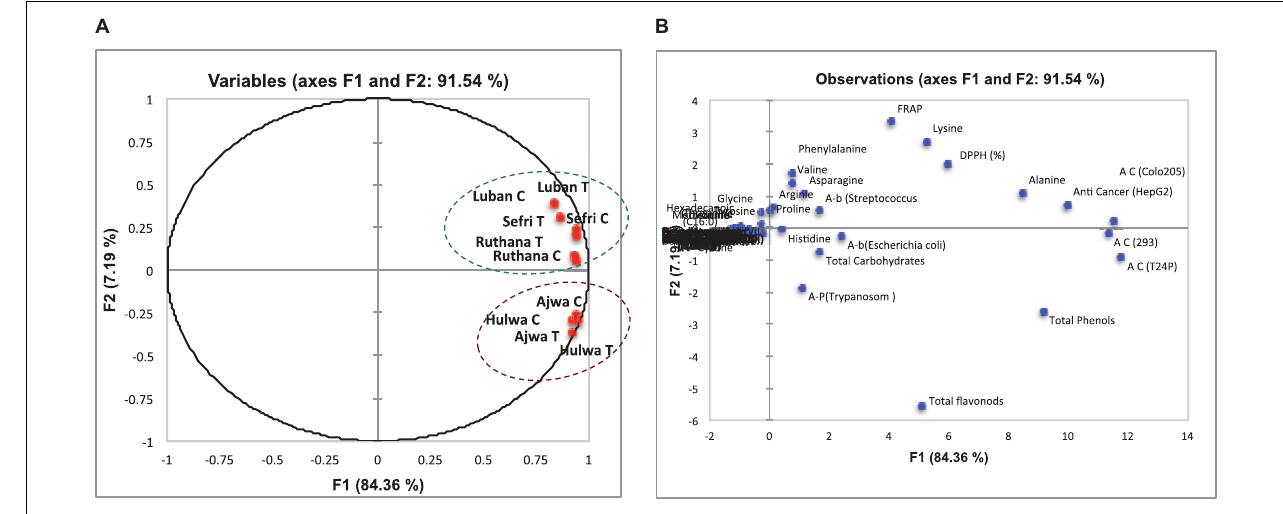
FIGURE 4 | Principal component analysis (PCA) of the measured metabolites, mineral concentrations and bioactivities of the ethanol extracts of vermicompost-fertilized and unfertilized date fruits of P. dactylifera cv. Ajwa, Hulwa, Ruthana, Sefri, and Luban (A) . PCA-plot separating the date palm cultivars and (B) the measured metabolites, mineral concentrations, and